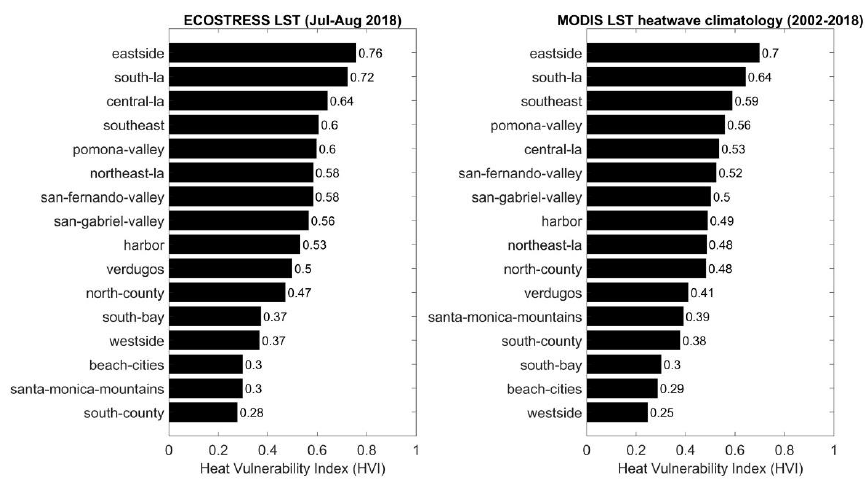
Figure 5. Histograms showing ranking of regions with highest average HVI derived from exposure variable driven by ECOSTRESS LST images from July–Aug 2018 (left), and from MODIS LST heatwave climatology from 2002–2018 (right).